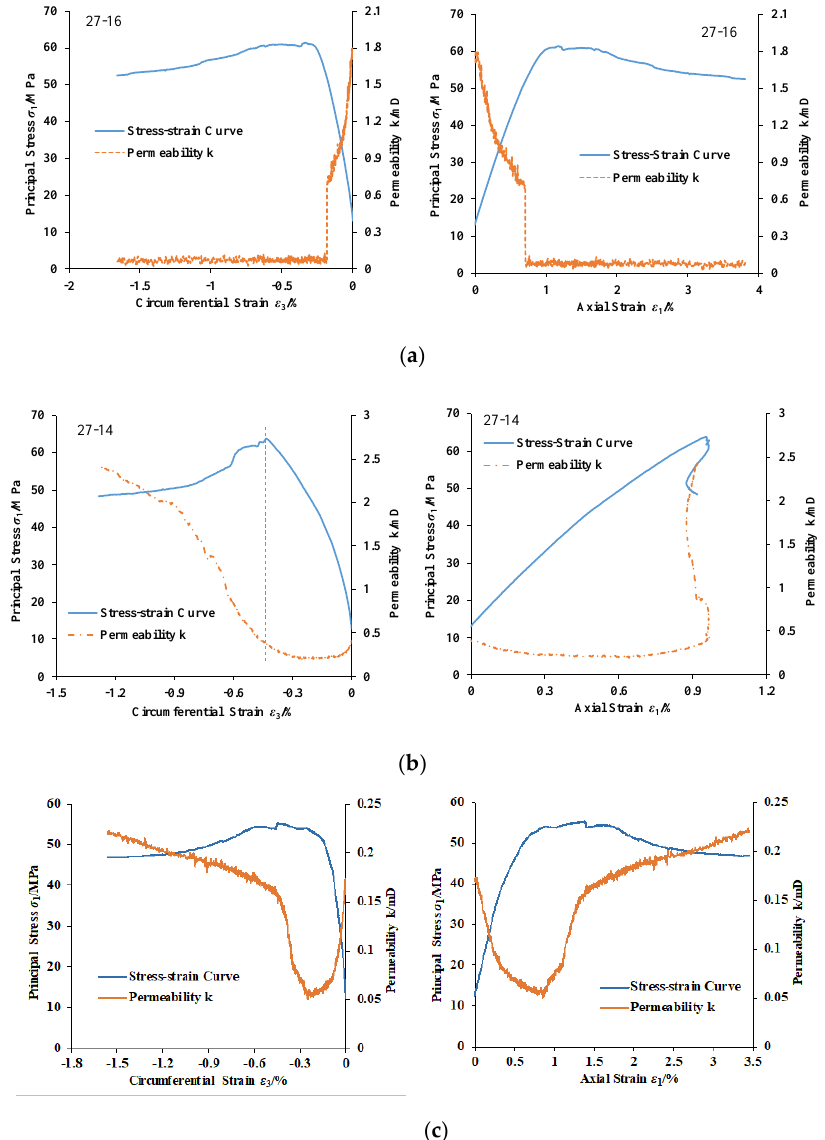
Figure 5. Relationship between permeability and axial strain or circumferential strain during loading of coal: ( a ) 27-16 (0.5 MPa); ( b ) 27-14 (1 MPa); ( c ) 27-15 (2